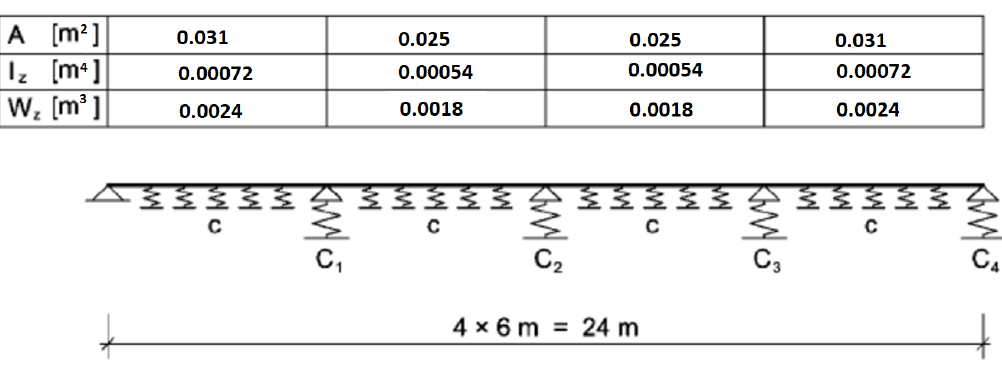
Figure 2. Example 1: description taken from [7], Section 5.4.